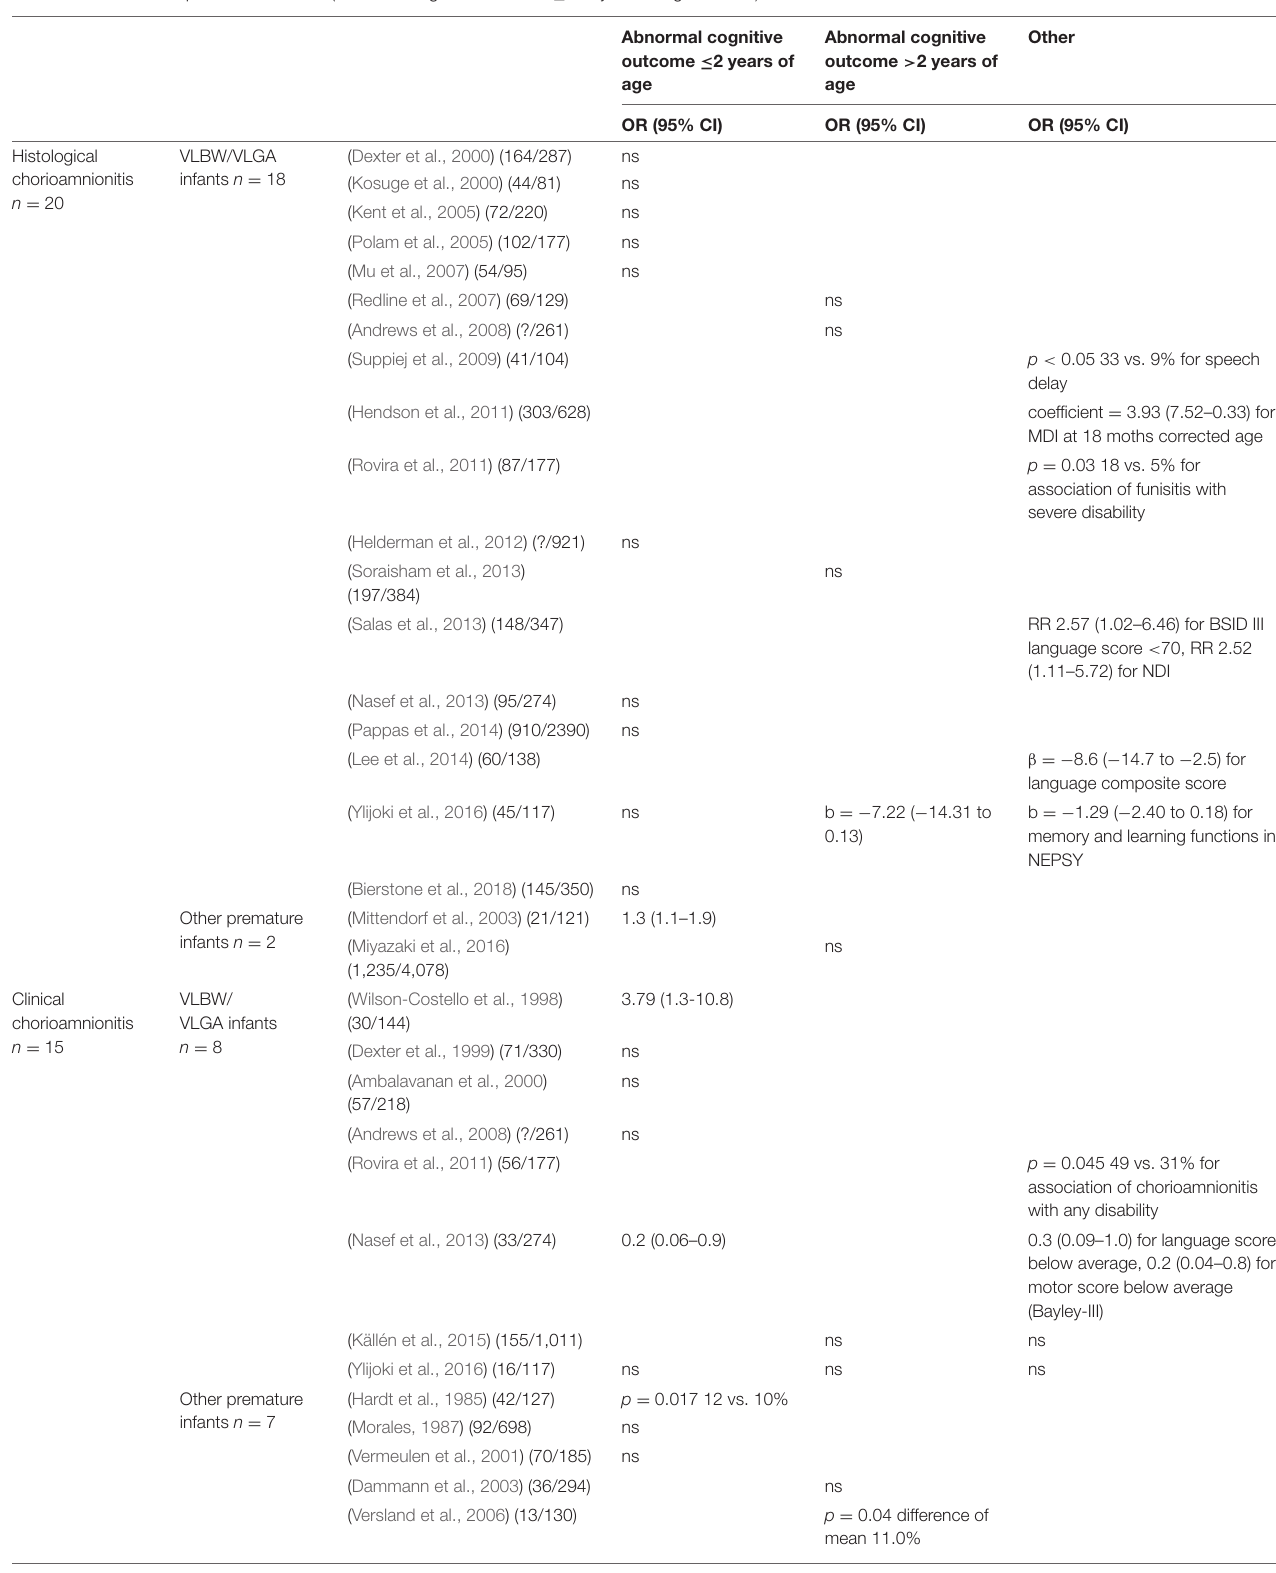
Abnormal cognitive Abnormal cognitive Other outcome ≤ 2 years of outcome > 2 years of age age OR (95% CI) OR (95% CI) OR (95% CI)